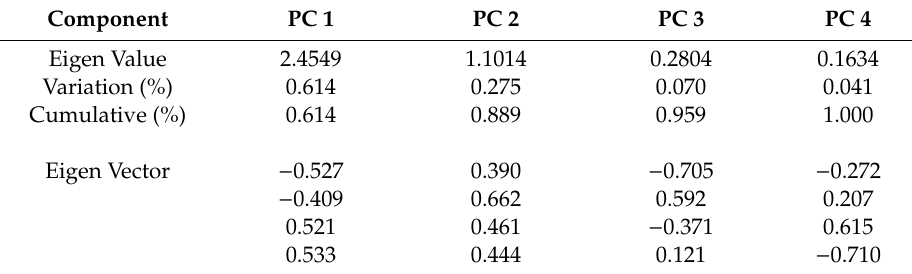
Table 4. Principal component